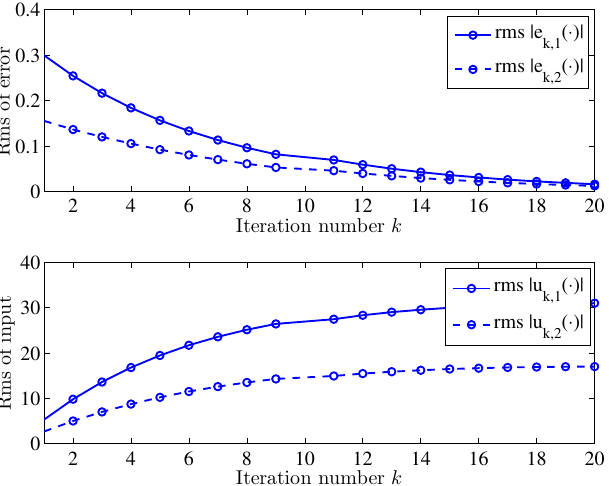
Figure 3. Trajectories of z k ( x , t ) at several specified iterations using open-loop iterative learning schemes (13).